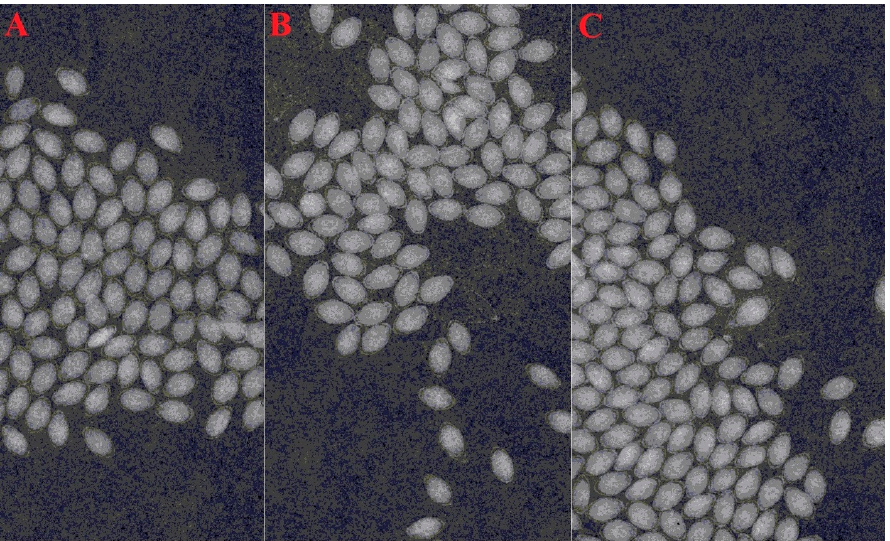
Figure 1. X-ray image of three biotypes of the Brachiaria eruciformis seed: ( A ) from a mungbean field, ( B ) from a sorghum field, and ( C ) from fencelines.